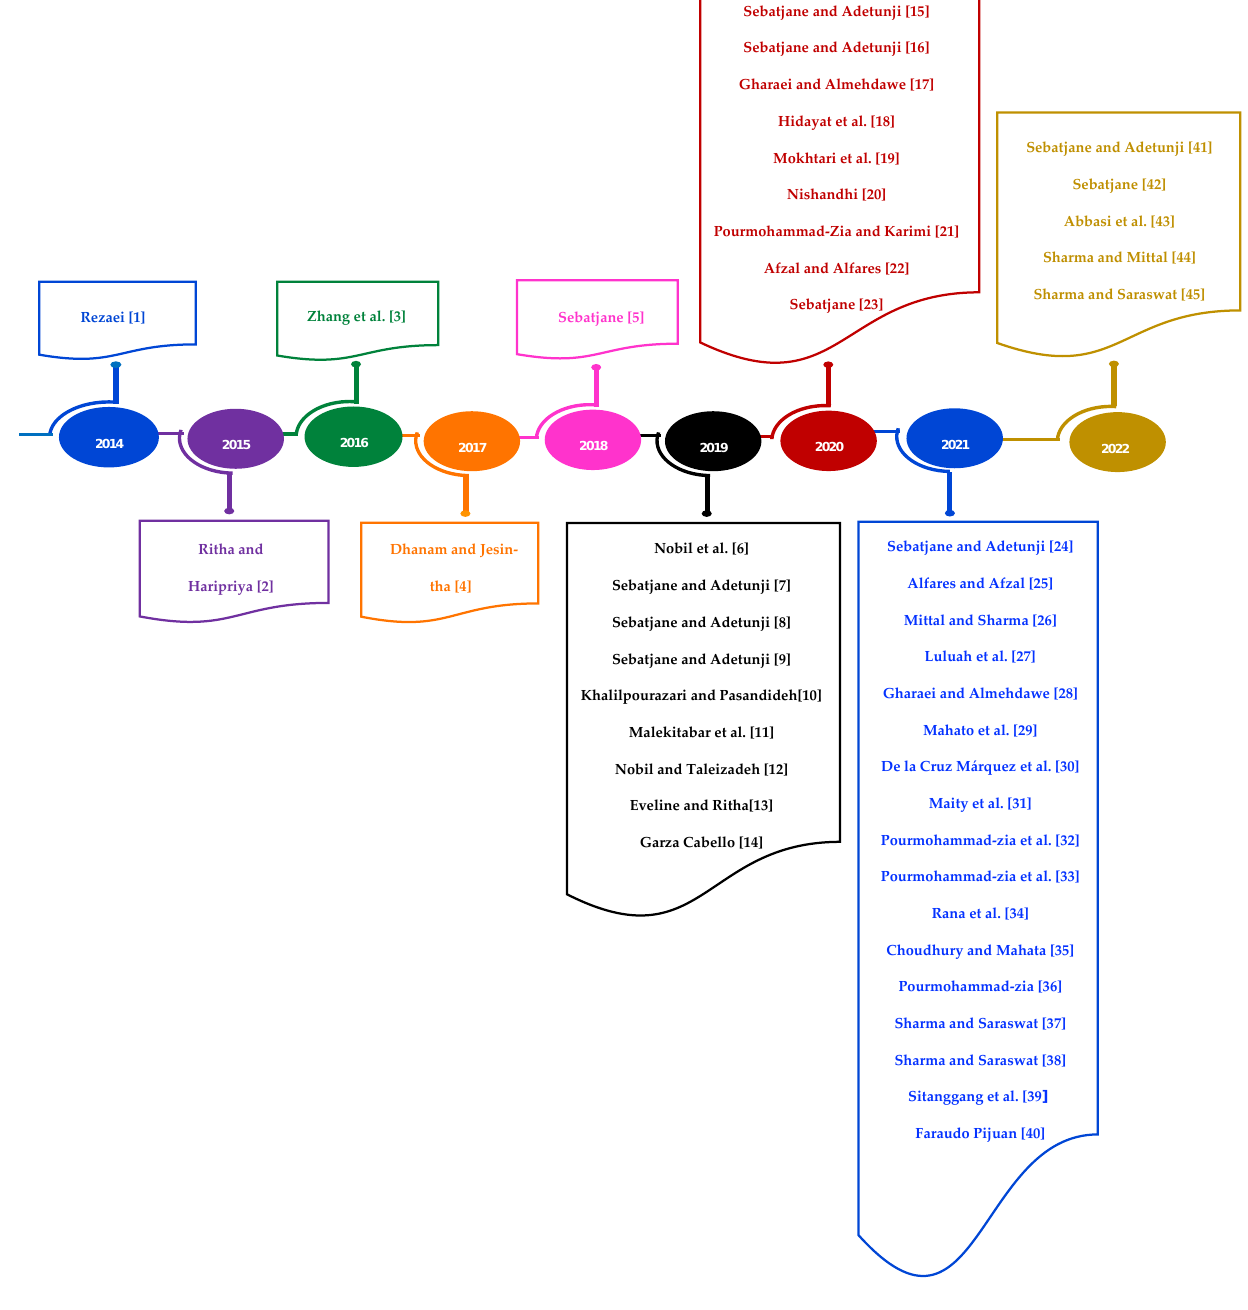
Figure 1. Inventory models with growing